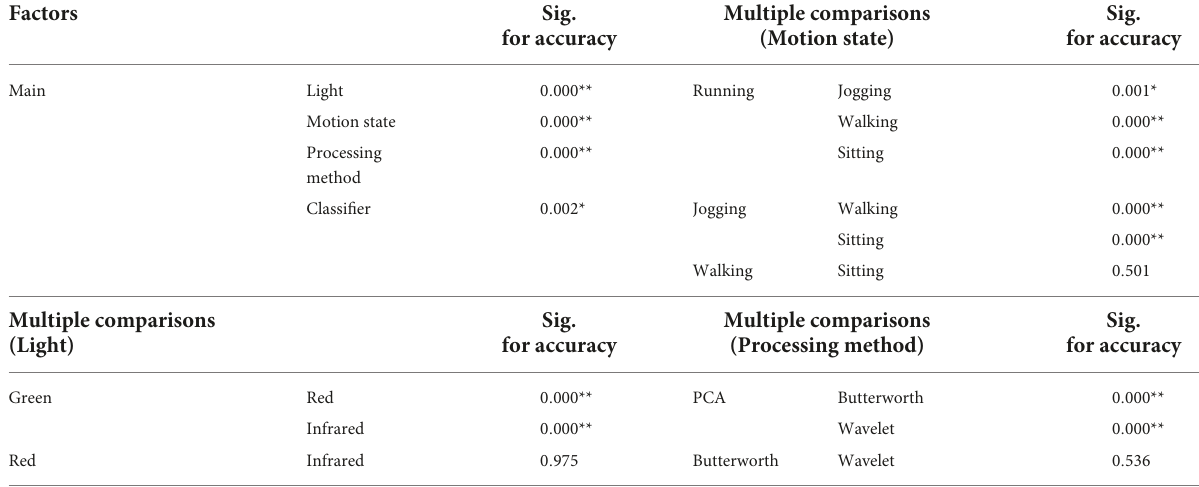
Multiple comparisons for accuracy (Motion state)